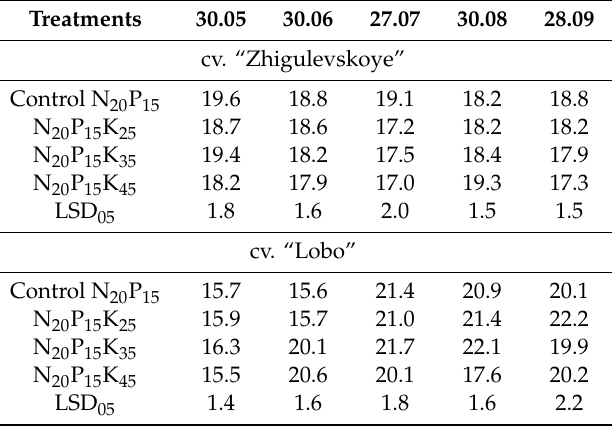
Table 10. Seasonal variations of the exchangeable soil calcium content in the experimental plots of di ff erent cultivars in 2017, Mmol 100 g − 1 .